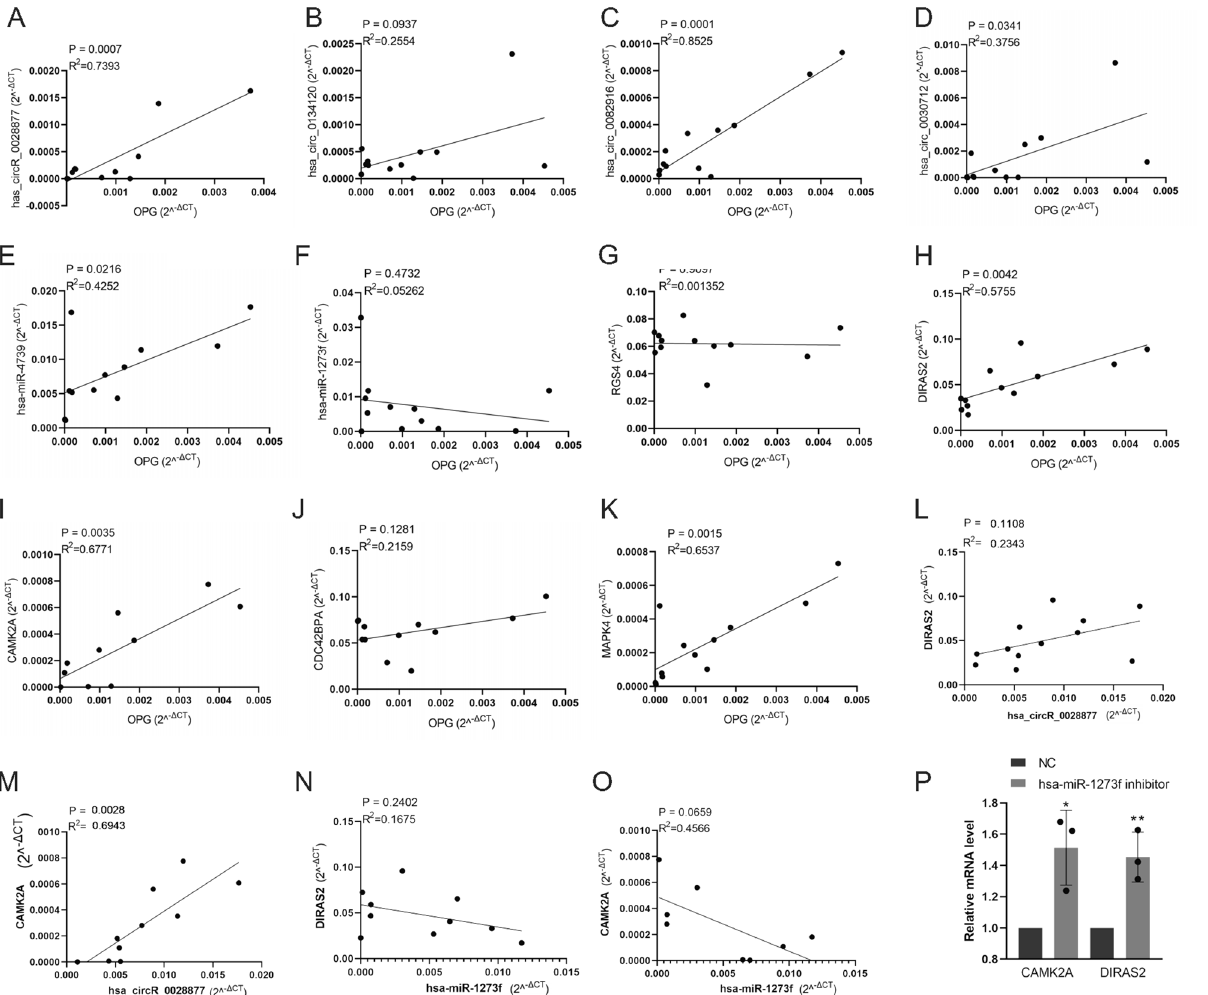
Figure 9. qRT-PCR correlation analysis of circRNAs, miRNAs, and mRNAs in the ceRNA sub-network with osteogenesis indicator OPG. ( A – D ) The correlation of circRNAs with OPG. ( E , F ) The correlation of miRNAs with OPG. ( G – K ) The correlation of mRNAs with OPG. ( L ) hsa_circR_0028877 expression positively correlated with DIRAS2. ( M ) hsa_circR_0028877 expression positively correlated with CAMK2A. ( N ) hsa-miR-1273f expression negatively correlated with DIRAS2. ( O ) hsa-miR-1273f expression negatively correlated with CAMK2A. ( P ) Inhibition of hsa-miR-1273f with an inhibitor in human BMSCs cells presents up-regulation of CAMK2A and